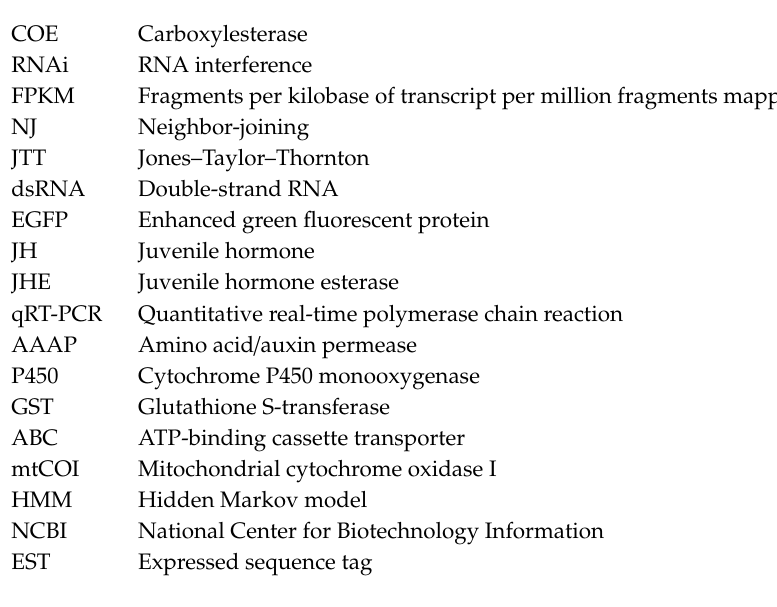
Table S3. FPKM values of the COE genes a ff ected by developmental stages of B. tabaci MED. Table S4. FPKM values from transcriptome data of COE genes in B. tabaci MED adults treated with an imidacloprid